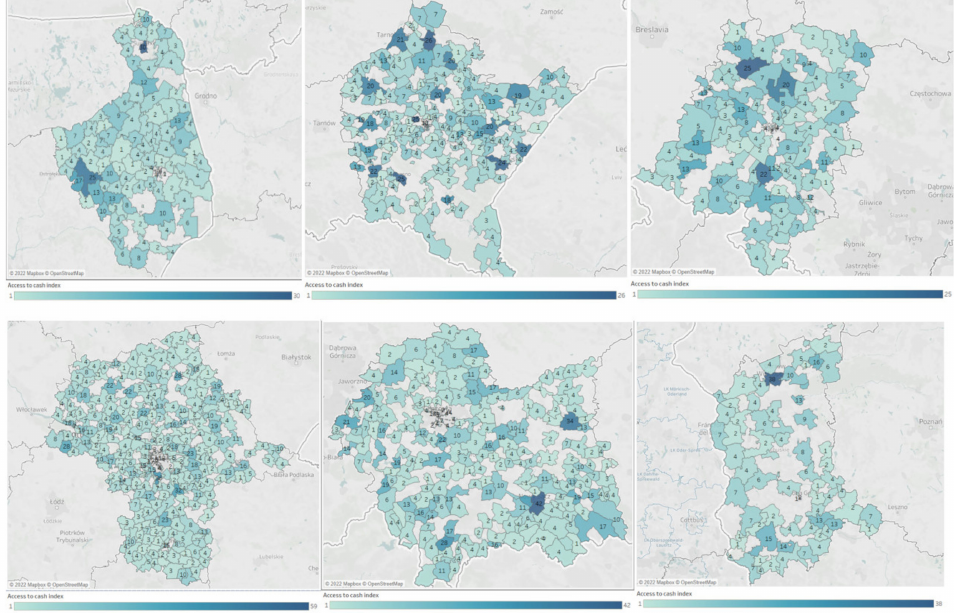
Figure 4. Results of the Access to cash index in Podlaskie, Podkarpackie, Opolskie, Mazowieckie, Małopolskie and Lubuskie voivodships. Source: Prepared by the authors using Tableau Desktop Professional